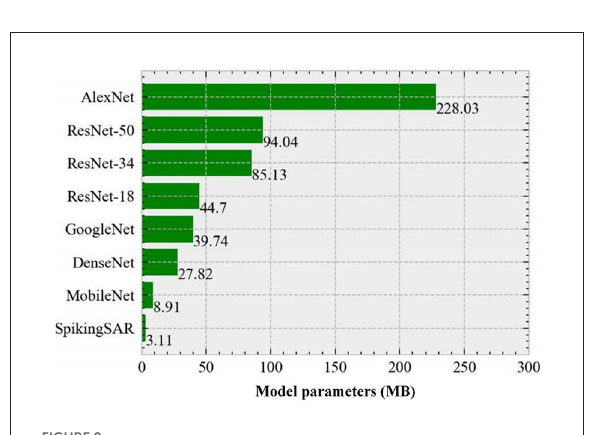
FIGURE9 Parameter comparison of the different neural network